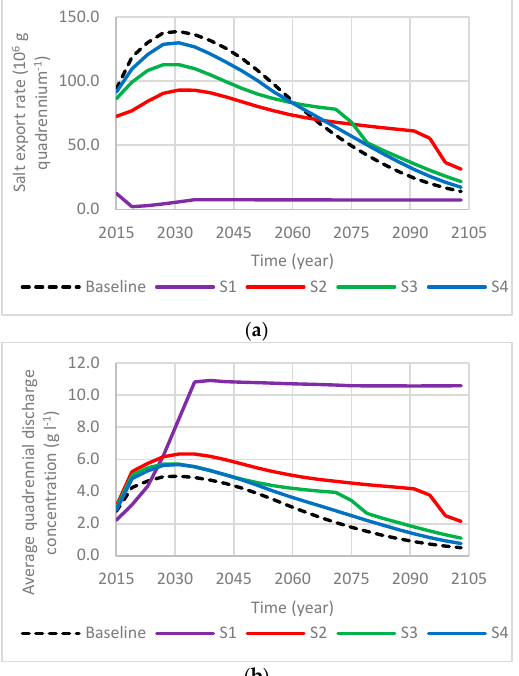
Figure 5. Simulated salt export rate ( a ) and average salt concentration of discharge flow ( b ) per every 4 years since the start of simulation.